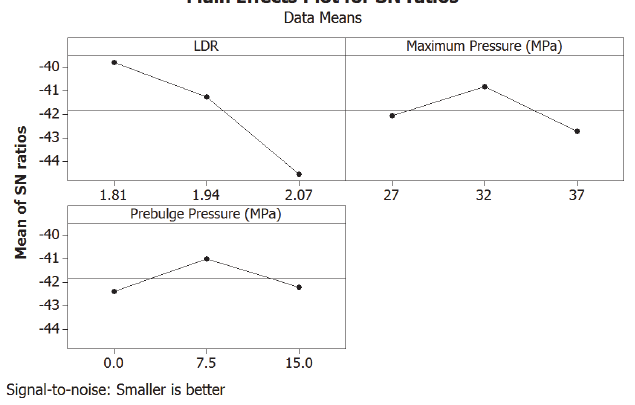
Fig. 5. S/N ratio for Final Thickness (FT) Fig. 6. S/N ratio for Forming Force (FF)